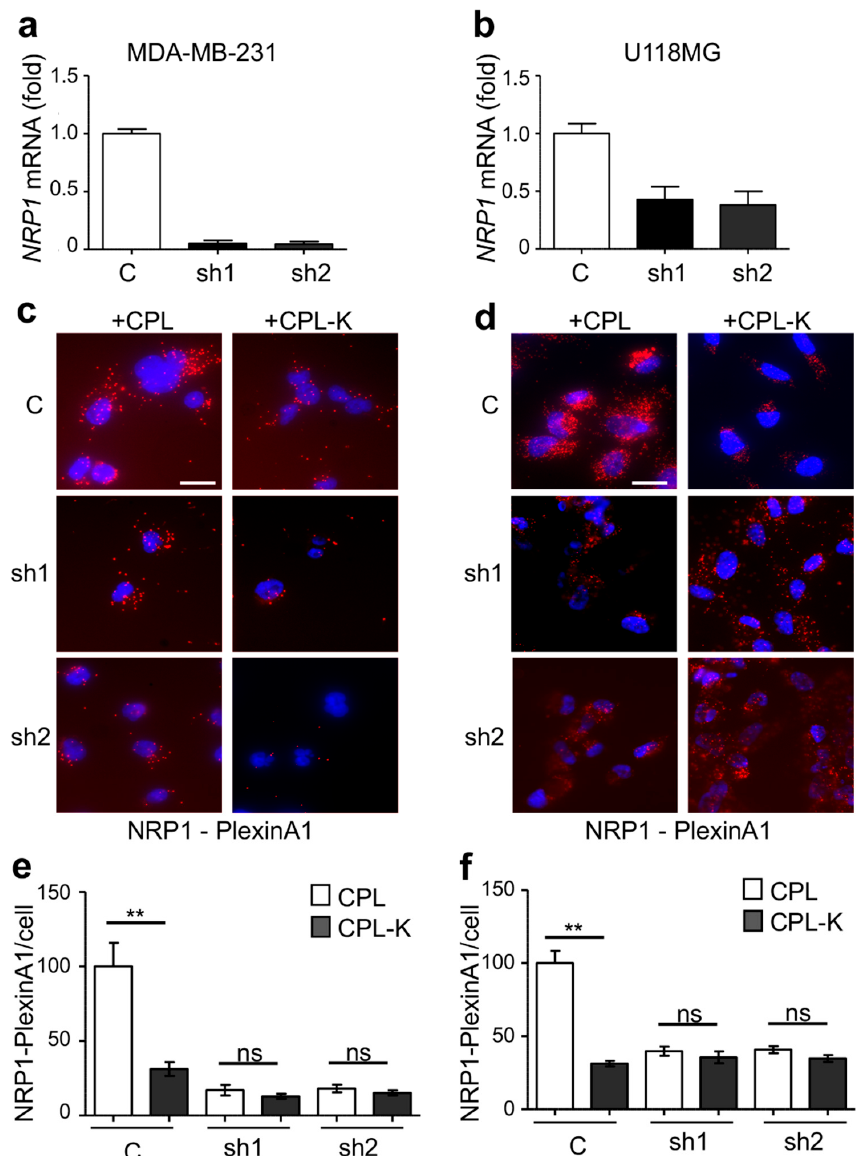
Figure 3. CPL-K disrupts NRP1/PlexinA1 complex formation. ( a , b ) Downregulation of NRP1 with shRNA constructs (sh1, sh2) in MDA-MB231 cells ( a ) and U-118MG cells ( b ) as determined by RT-qPCR. ( c – f ) Imaging ( c , d ) and quantification ( e , f ) of NRP1/PlexinA1 complex formation as determined by PLA with antibodies for NRP1 and PlexA1 in the presence of 1 µM CPL or CPL-K in MDA-MB-231 ( c , e ) and U-118MG cells ( d , f ) and, upon knockdown of NRP1. Scale bar, 20 µm. ** p < 0.005; ns = not significant (one-way ANOVA and Dunn’s multiple comparison test).